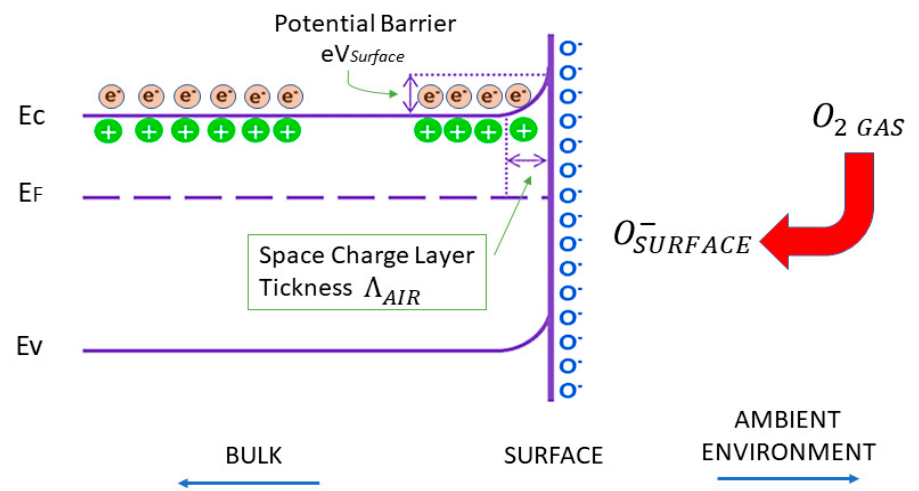
Figure 2. Schematic diagram of band bending after chemisorption of charged species (here the ionosorption of oxygen). E C , E V , E F and eV surface denote the energy of the conduction band, valence band, the Fermi level and the potential barrier, respectively while Λ air denotes the thickness of the space-charge layer. The conducting electrons are represented by e – and the symbol + represents the donor sites.